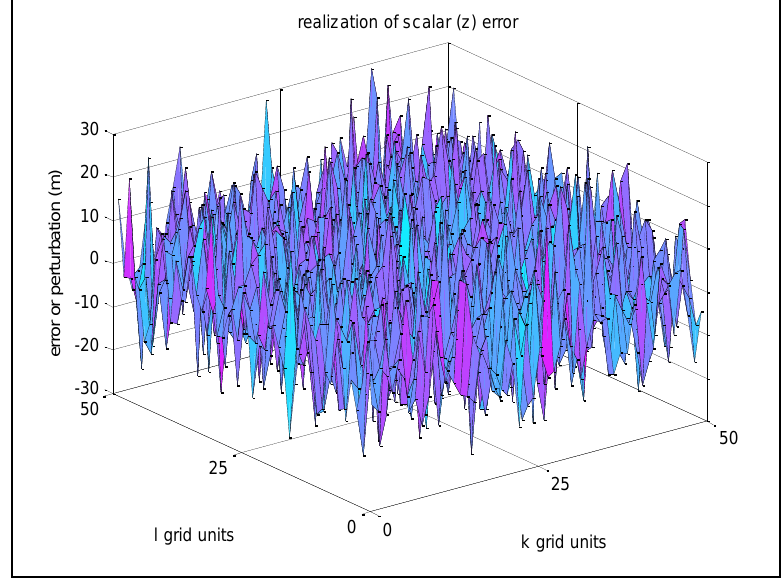
Figure 5. Example 2—Realization of -error with low spatial correlation between adjacent grid points.